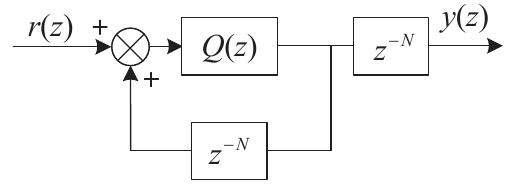
Figure 2. Block diagram of